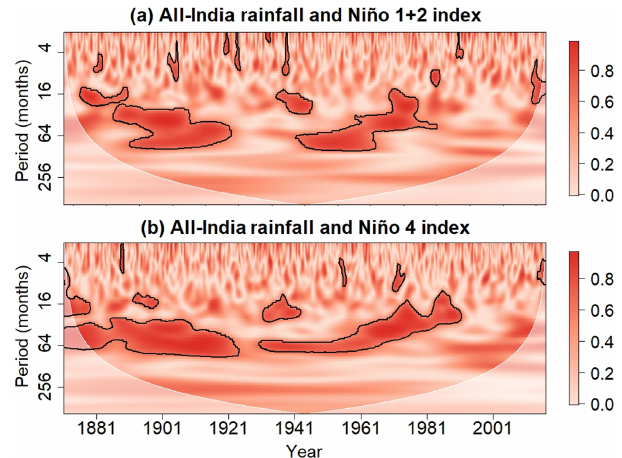
Figure 9. Nonlinear wavelet coherence between the full AIR time series and full times series for the (a) Niño 1 and 2 and (b) Niño 4 indices. Contours enclose regions of 5% cumulative area-wise significance, and the shading represents the cone of